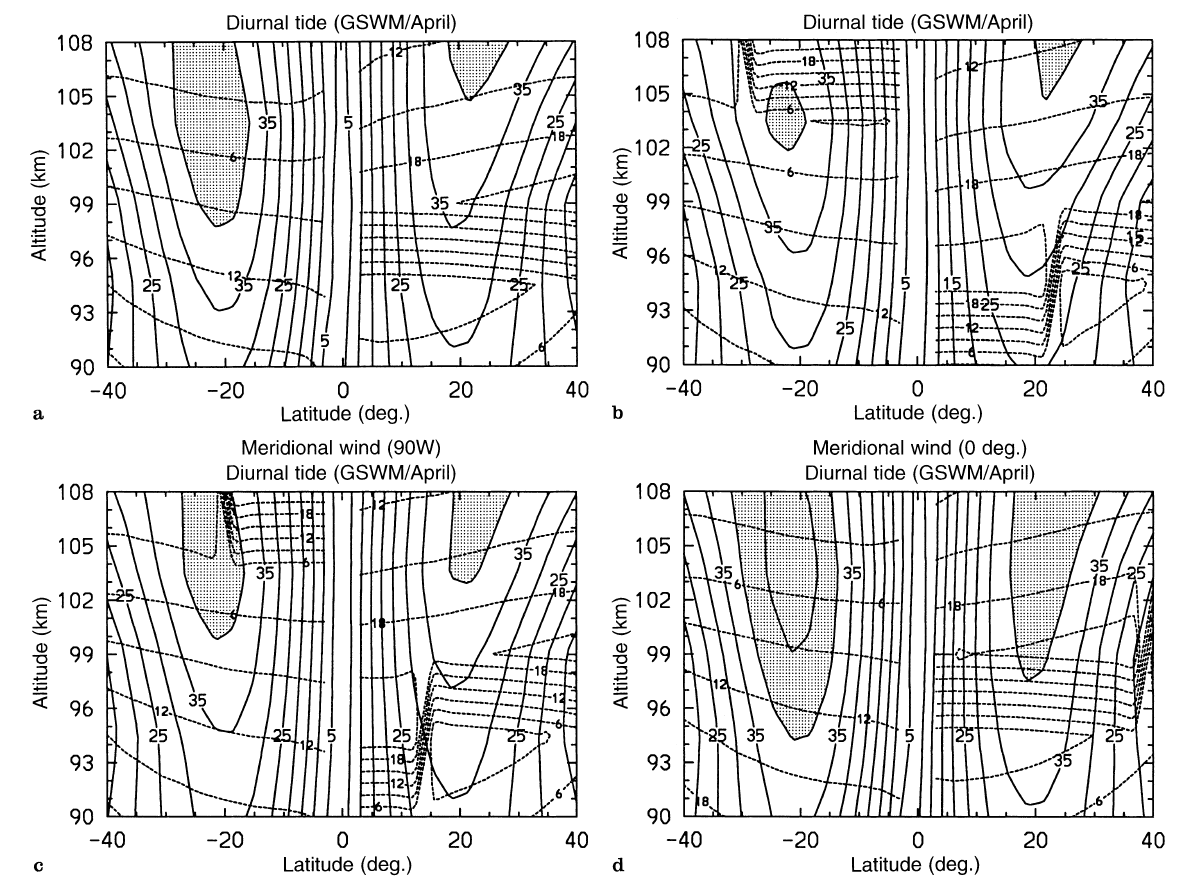
contours >40 m/s are shaded. The phase (local time of maximum) is contoured using a 3-h